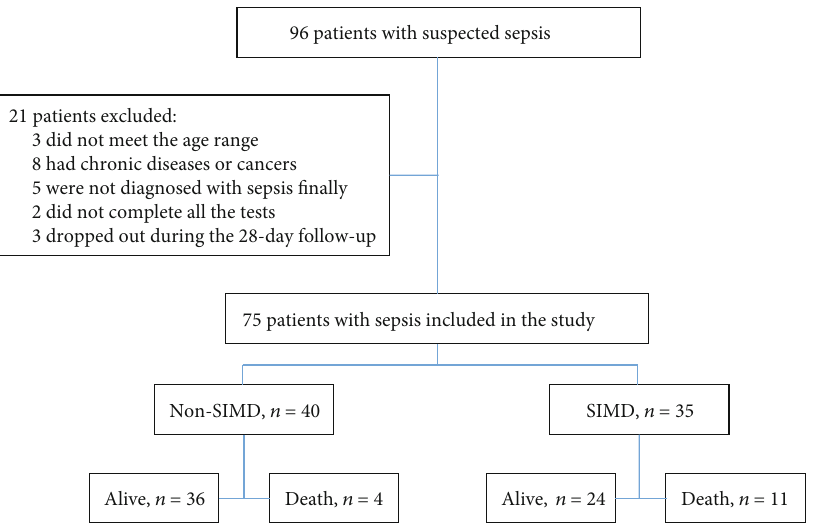
Figure 1: Flow diagram and outcome of the study participants. SIMD: sepsis-induced myocardial dysfunction. Table 1: Demographic and clinical data of the study population. Values expressed in percentages (%) indicate the proportion of patients within each cohort for each variable. Data are presented as median with interquartile ranges (IQR) where speci fi ed. SIMD: sepsis-induced myocardial dysfunction; BMI: body mass index; BP: blood pressure; CRP: c-reactive protein; PCT: procalcitonin; APACHE: Acute Physiology: Age and Chronic Health Evaluation; SOFA: Sequential Organ Failure Assessment; NT-proBNP: N-terminal